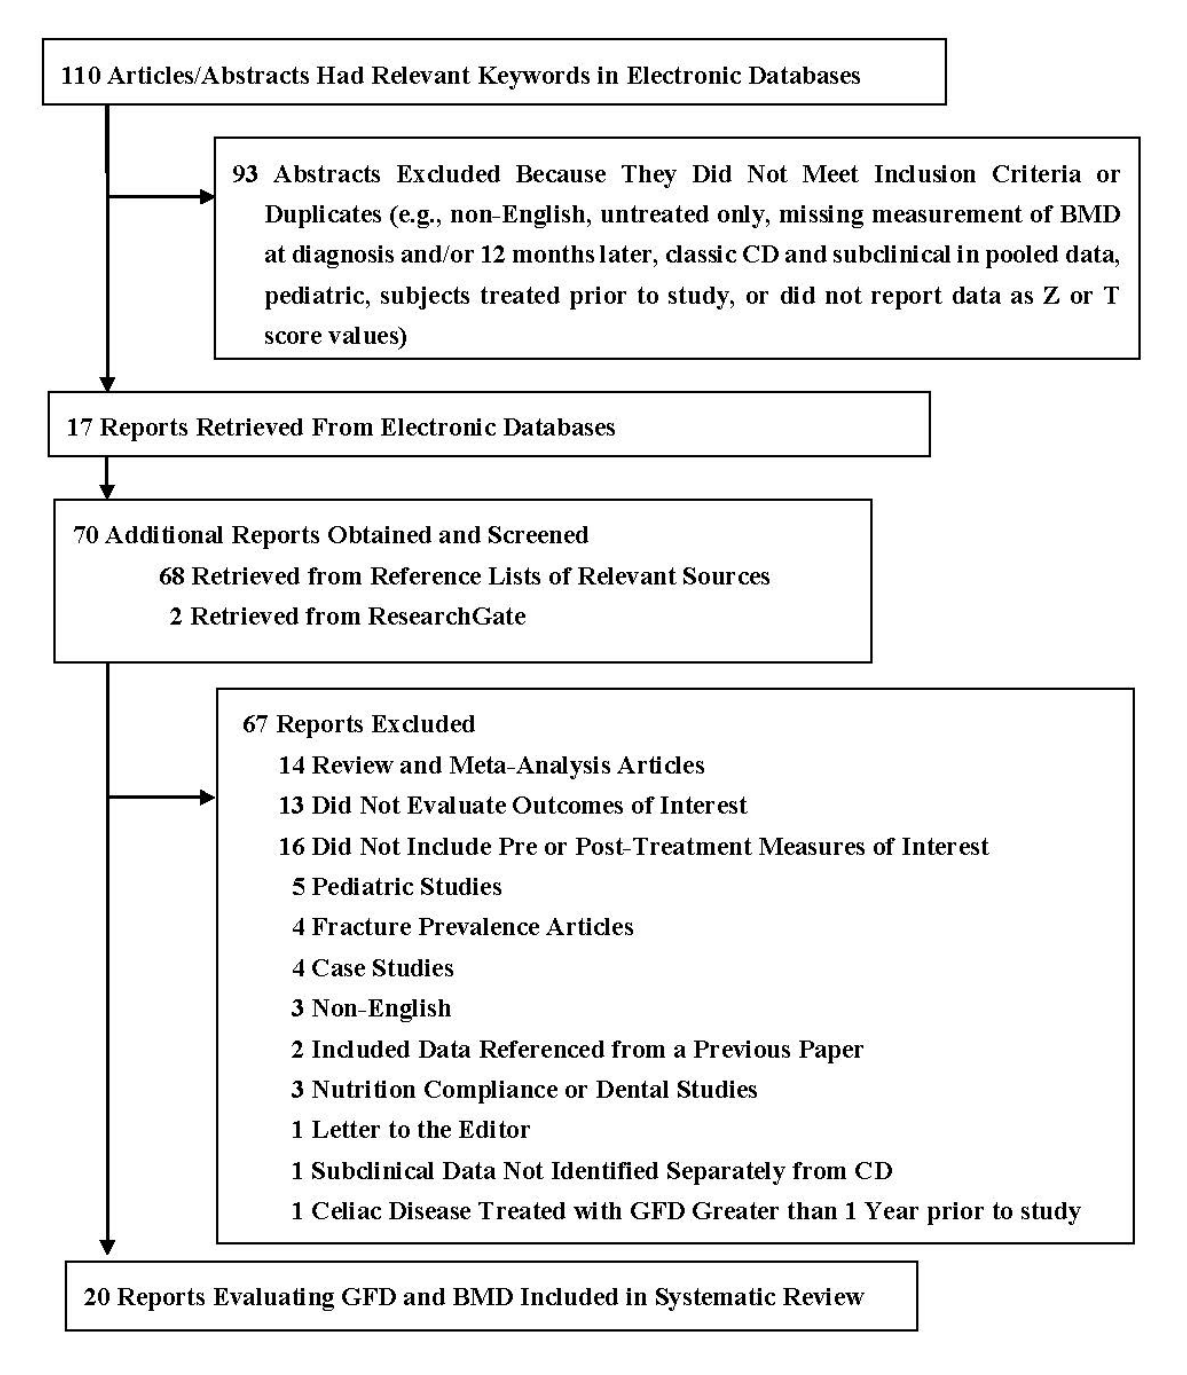
Figure 1. Selection process for studies included in the systematic